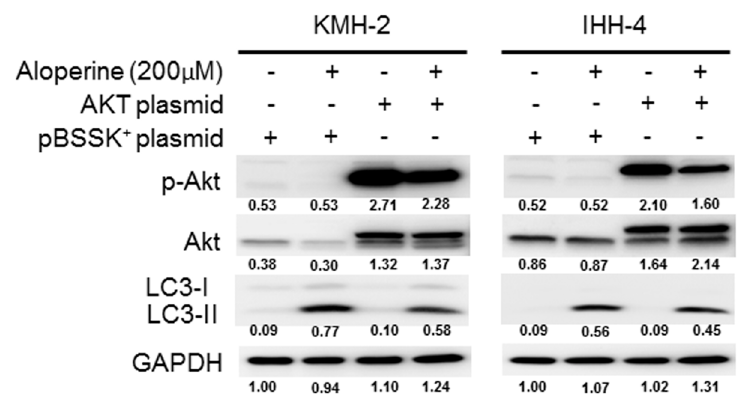
Figure 8. Suppression of aloperine-mediated autophagy induction via compensation of phospho-Akt. Human thyroid cancer cells were transfected with a constitutively active-form Akt construct or a vacant construct. Phospho-Akt and LC3 expression in cells with or without aloperine treatment for 24 h was examined using Western blotting. DMSO was used as a negative control. Numbers under the plots indicate the quantification of protein intensity after normalization with GAPDH. Three independent experiments were performed, and results of one of these are shown.